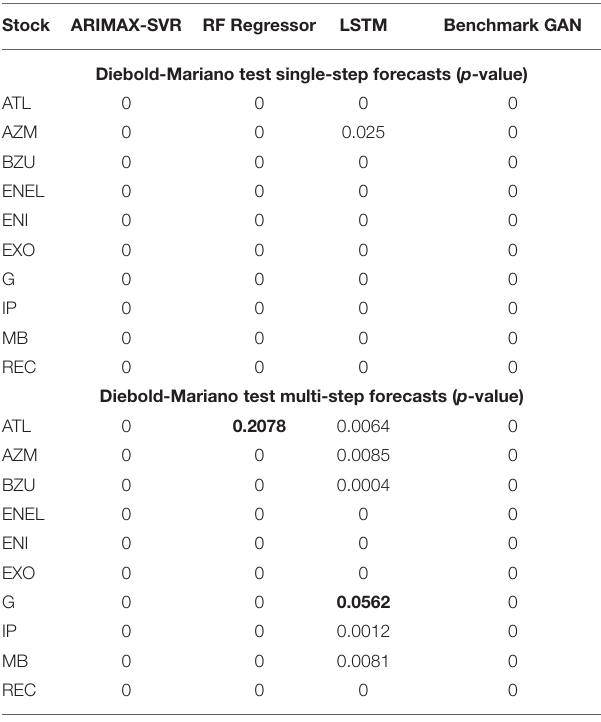
TABLE 5 | Diebold-Mariano test for the single-step and multi-step forecasts. Stock ARIMAX-SVR RF Regressor LSTM Benchmark